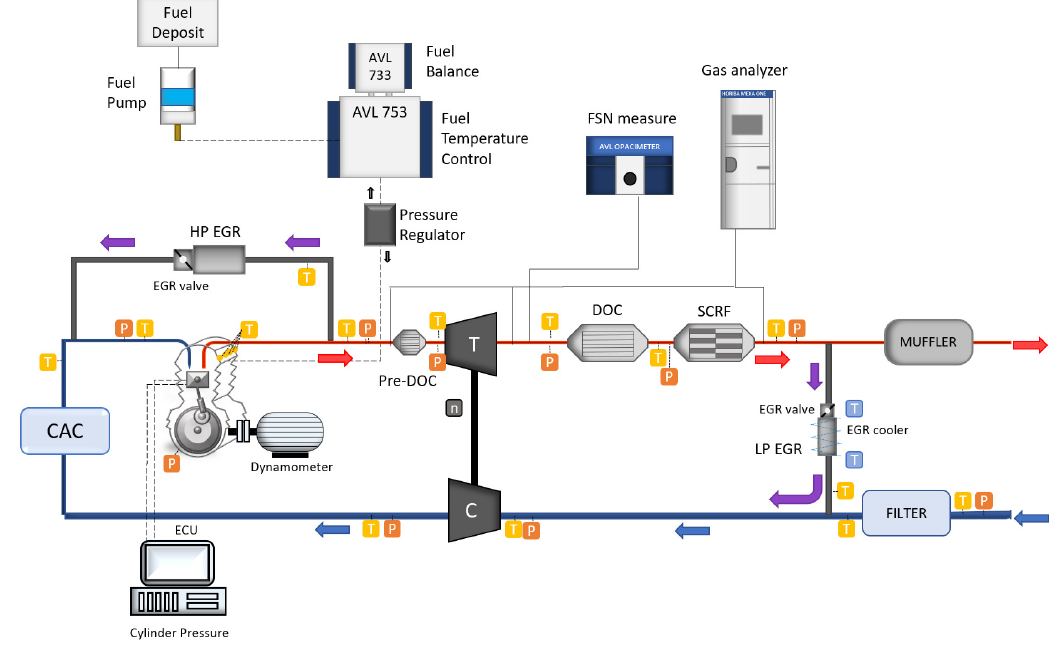
Figure 1. Scheme of the engine (with pre-turbine pre-DOC) and experimental